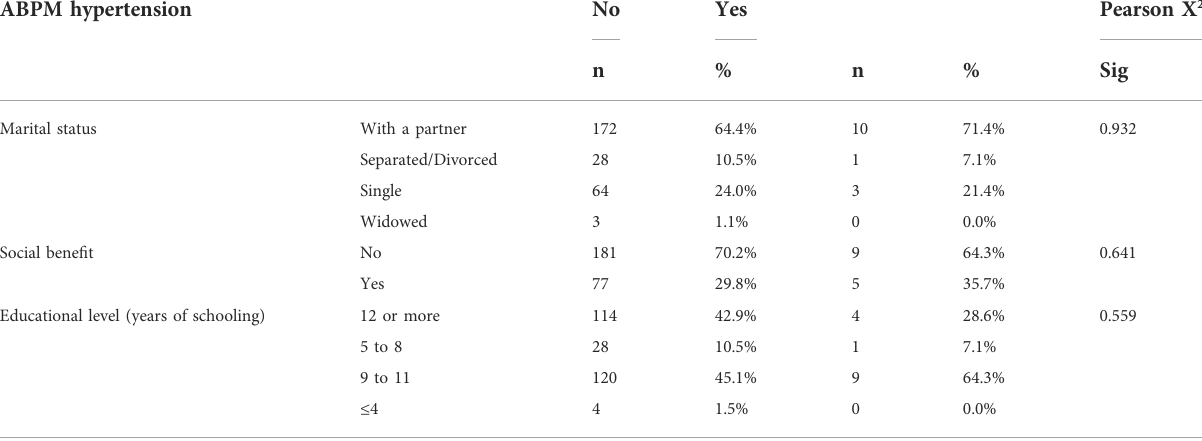
TABLE 2 Evaluation of the presence of hypertension (ABPM) according to demographic variables.